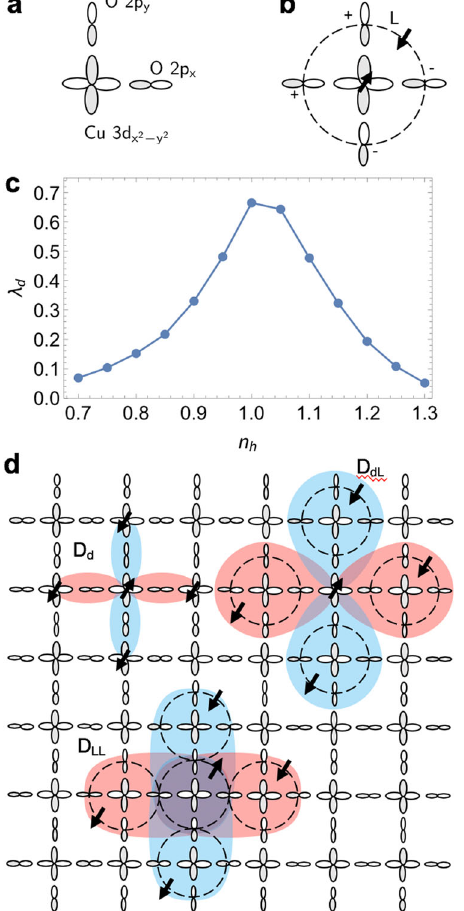
Fig. 1 Orbitals, pairing correlations, and possible pair structures in the three-band Hubbard model. a The orbital basis of the three- band Hubbard model. b Sketch of the bonding ligand ( L ) molecular orbital surrounding a central Cu- d orbital, the two orbitals relevant for the Zhang – Rice singlet. c Leading BSE eigenvalue λ d vs n h for a 4 × 4 cluster at β = 16 eV − 1 . d Sketches of some ways a pair can form with a d -wave symmetry. Here, D d and D dL pair a Cu 3 d hole with a hole on the neighboring Cu- d and L molecular orbital, respectively, while D LL pairs holes on neighboring O – L